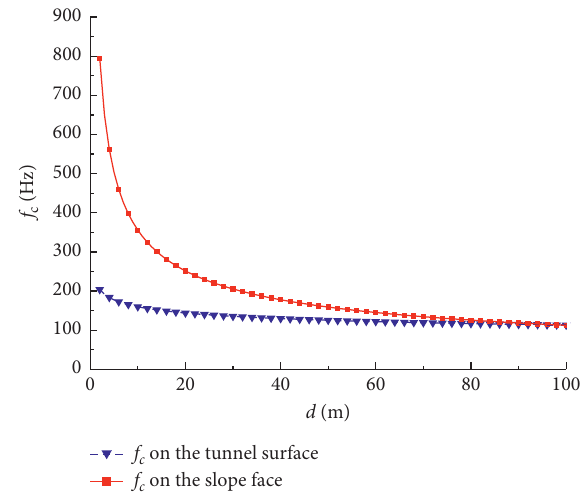
Figure 10: Center frequency of the blasting vibration at varying